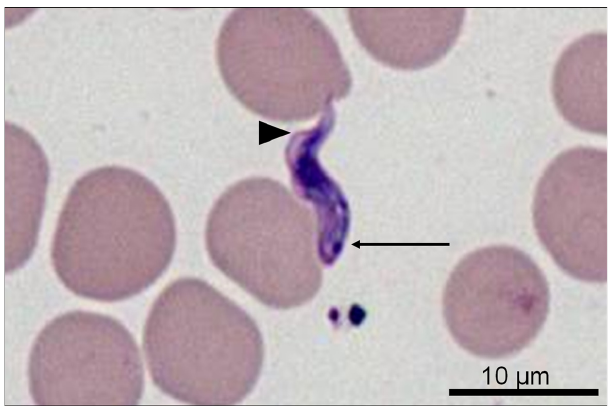
Figure 3. The protozoa are 10–20 l m in length and characterized by a central nucleus, a medium-sized kinetoplast located at the margin of the body, in a sub-terminal position (arrow), a poorly- developed undulating membrane (arrowhead) and no free flagellum (May-Grünwald-Giemsa stain).